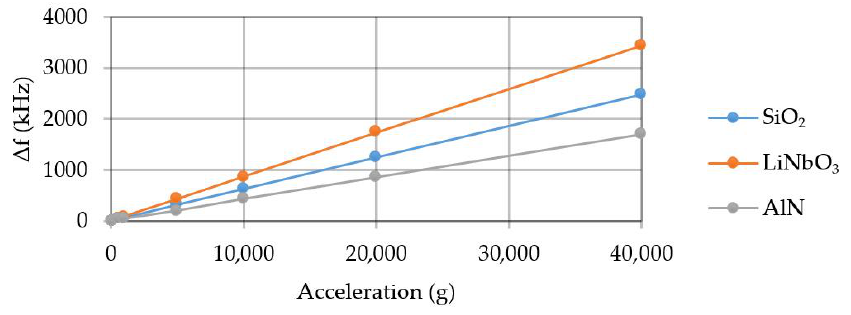
Figure 11. Graph of the frequency change under acceleration.